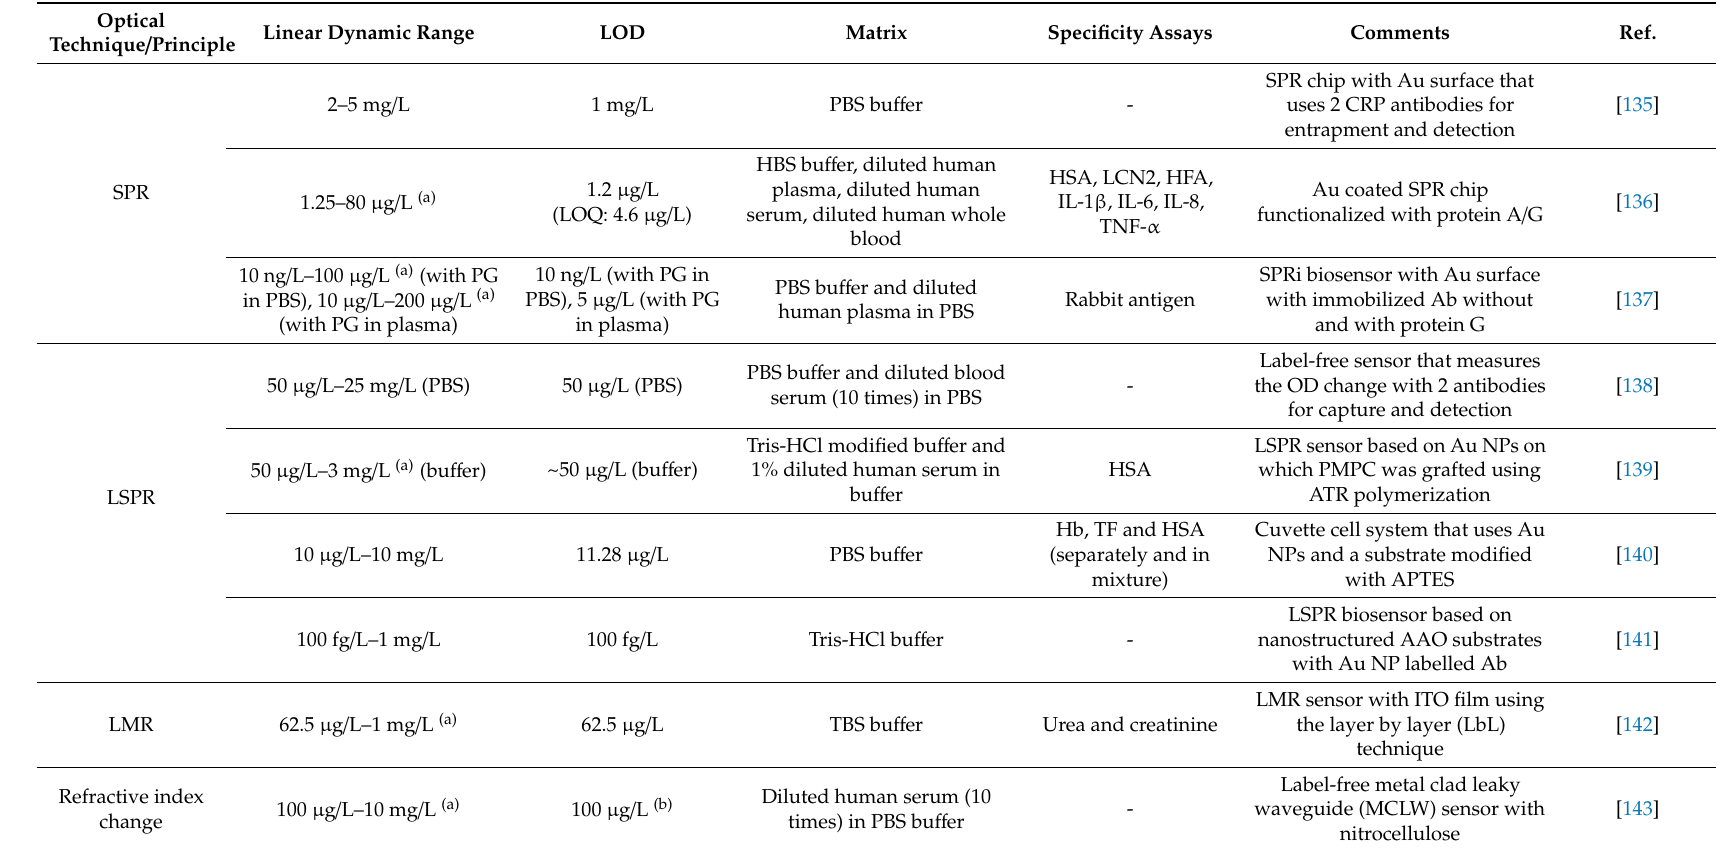
Table 4. Optical biosensors for C-reactive protein (CRP)